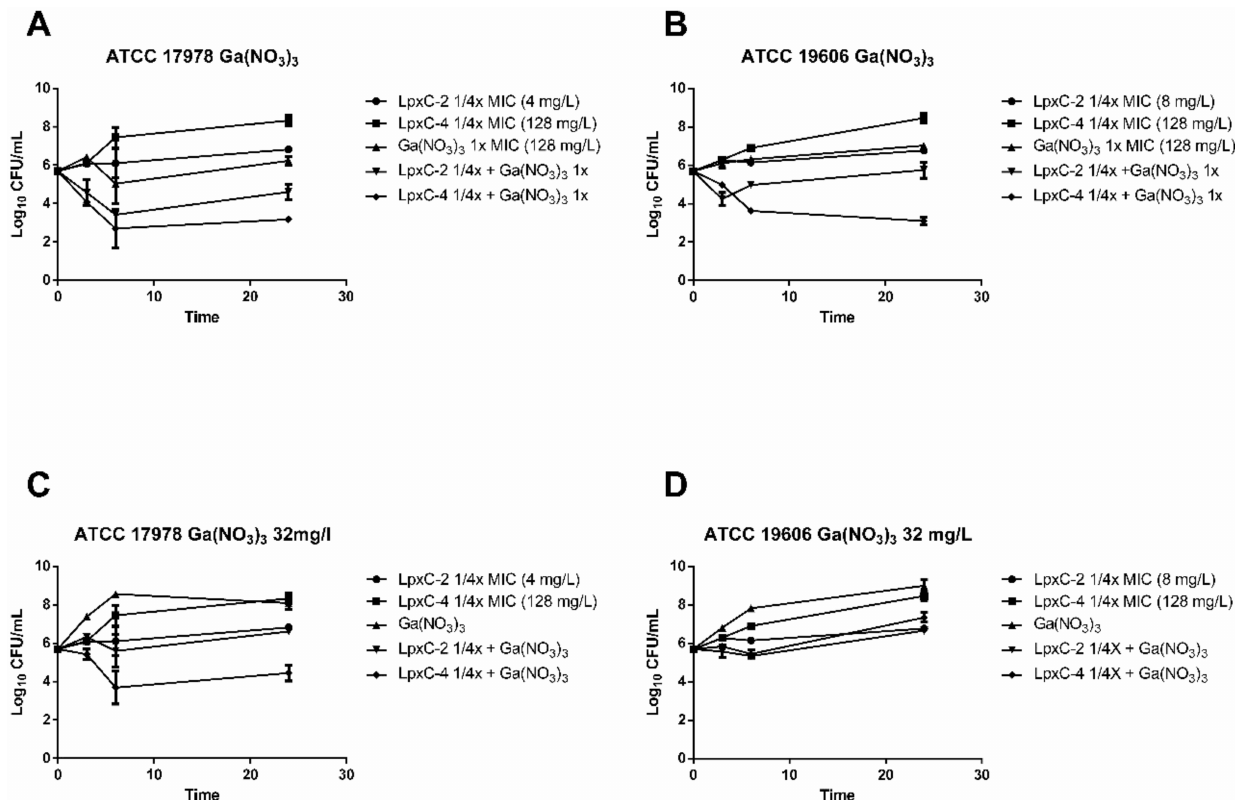
Figure 2. Time–kill curves for gallium nitrate in combination with LpxC inhibitors. Time–kill curves indicating bacterial counts in cultures at 0, 3, 6 and 24 h with the indicated A. baumannii strains containing combinations of Ga(NO 3 ) 3 with LpxC-2 and LpxC-4 ( A – D ) at the indicated concentrations. Time points indicate the mean bacterial count from a minimum of two biological replicates and error bars represent the standard deviation. Ga(NO 3 ) 3 , gallium